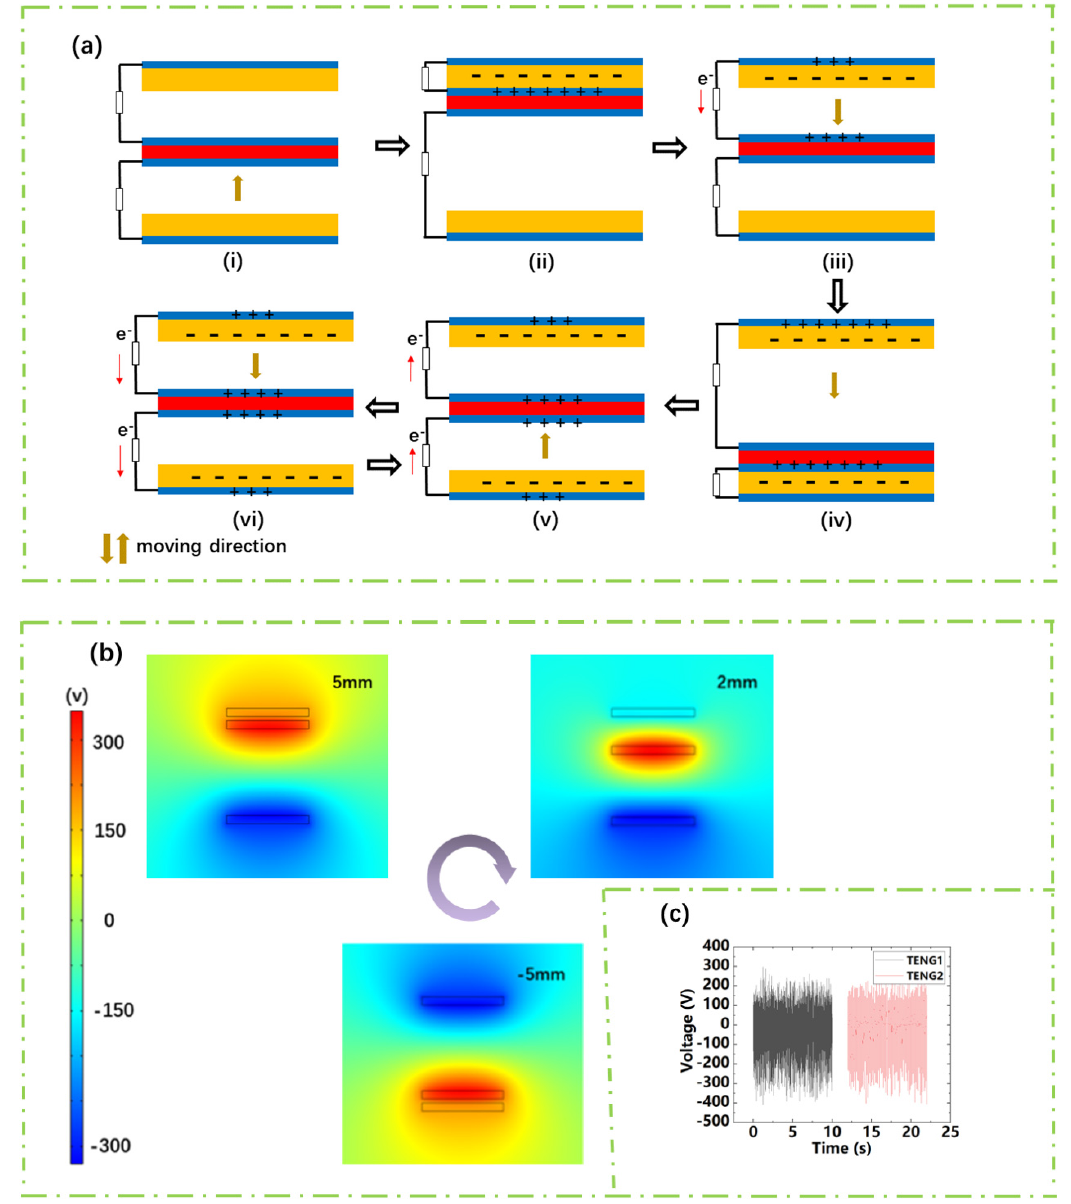
Figure 2. ( a ) Wind-TENG working principle. ( b ) Wind-TENG COMSOL simulation results. ( c ) TENGs open-circuit voltage.